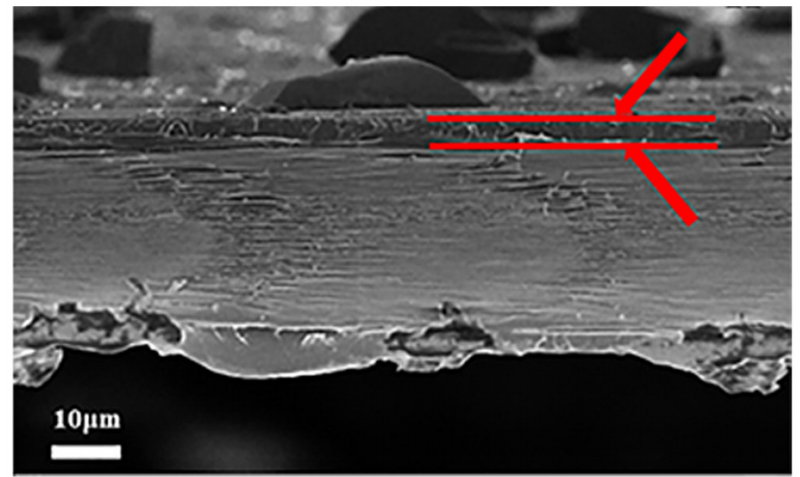
Figure 3. CP treatment effectively facilitated the grafting of nisin onto PLA film. Reprinted with permission from ref. [54]. Copyright John Wiley and Sons 2022.